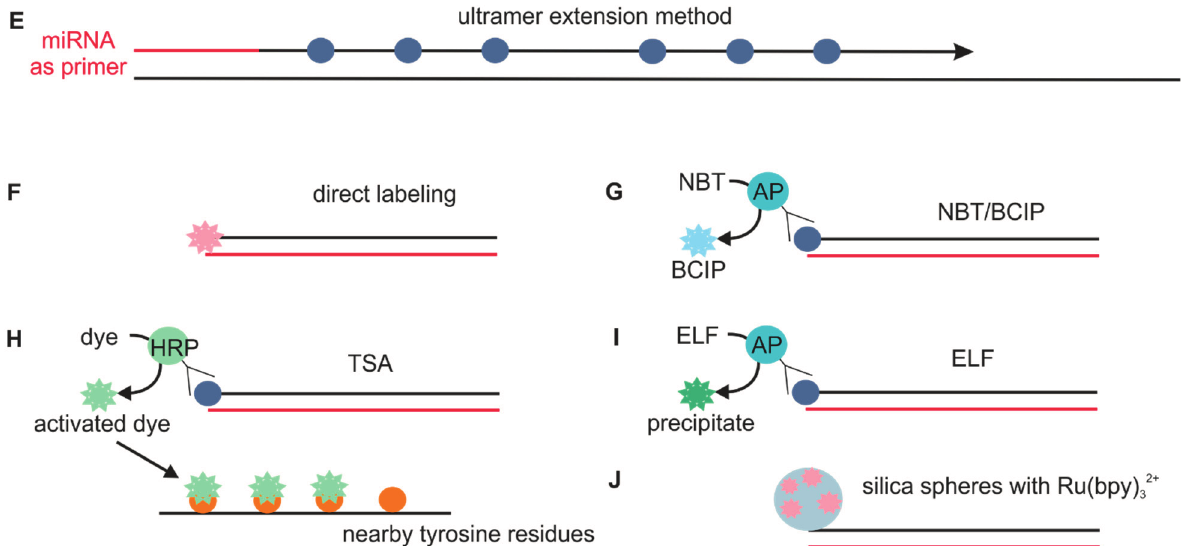
Figure 3. Sequence amplification and detection methods for small RNA ISH include ( A ) Padlock probes with RCA; ( B ) circular probes with RCA; ( C ) TIRCA; ( D ) O-FISH and ( E ) the ultramer extension method; Different methods for detection are also used for small RNAs including ( F ) direct labeling of probes (e.g., Cy3/fluorescein labeling); ( G ) NBT/BCIP; ( H ) TSA; ( I ) ELF and ( J ) silica spheres with Ru(bpy) 32+ . miRNA is presented as red line and probe is shown as black line. Violet dot represents non-fluorescent